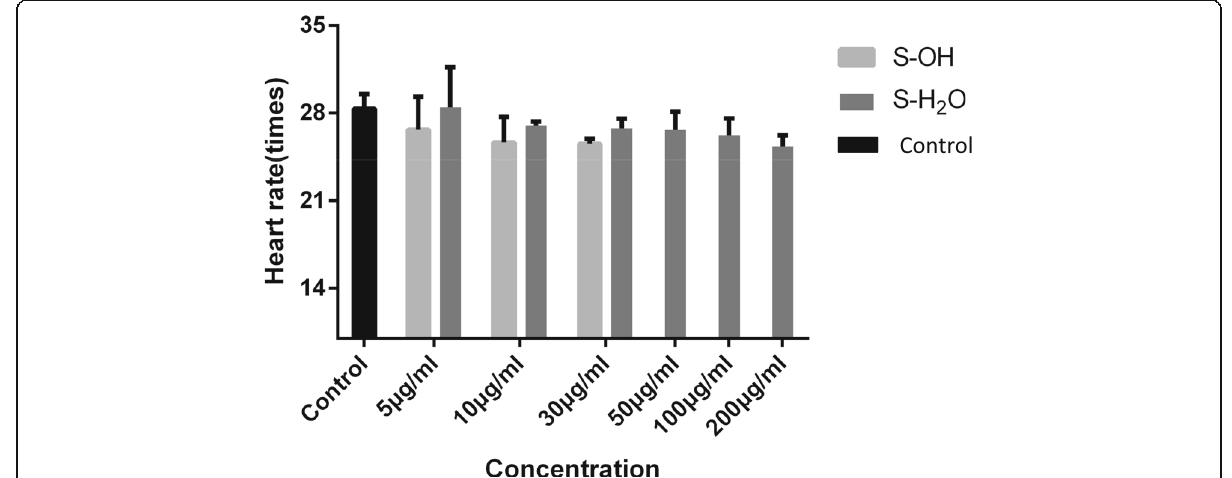
Fig. 3 Cardiotoxicity in zebrafish embryos caused by different concentrations of S.fru-OH (5, 10 and 30 μ g/ml) or S.fru-H 2 O (5, 10, 30, 50, 100 and 200 μ g/ml). The heart rate was measured at 96 hpf and the values are described as mean ± SD